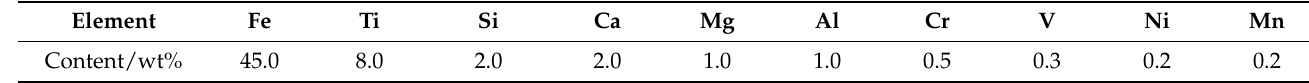
Table 1. The main components of